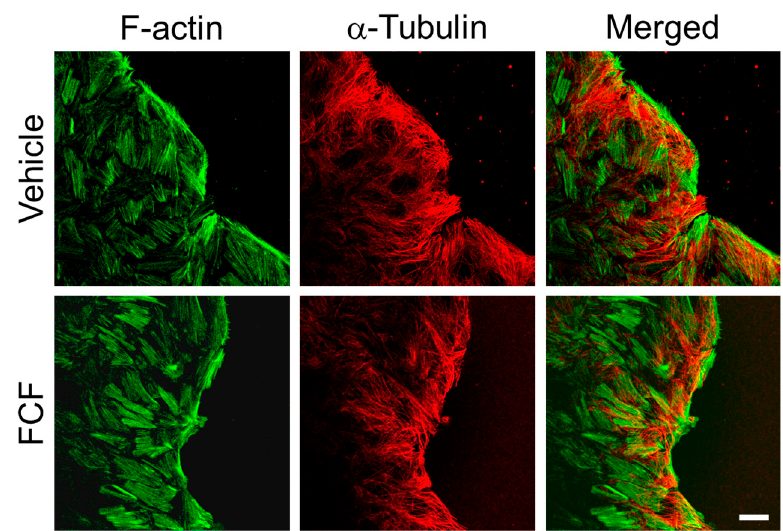
Figure 7. Forchlorfenuron does not affect the actin or microtubule cytoskeleton in migrating colonic epithelial cells. Control and SEPT7-depleted HT-29 cell monolayers were wounded and allowed to migrate for 12 h. Cells were fixed and subjected to dual fluorescence labeling for F-actin (green) and α -tubulin (red). Scale bar, 20 µm.